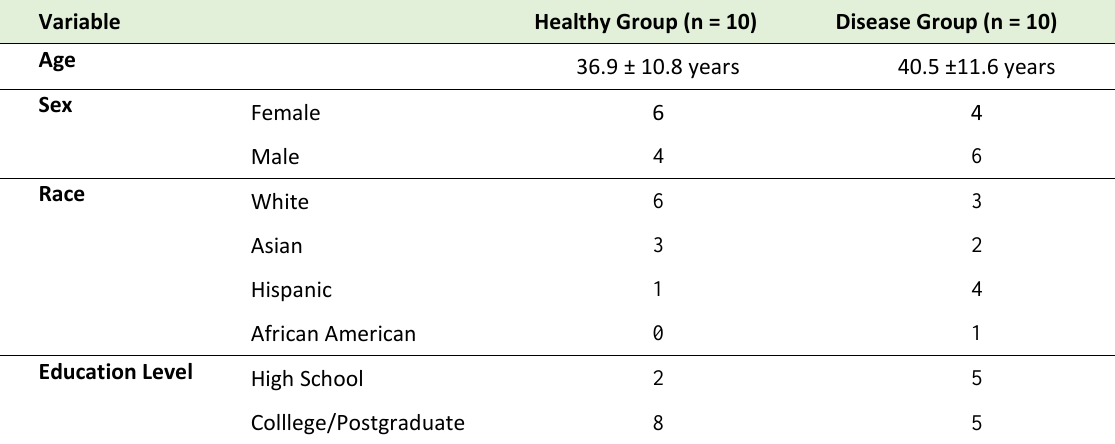
TABLE 1. Demographic characteristics (mean and SD) of subjects in the Healthy and Disease groups (N = 20).